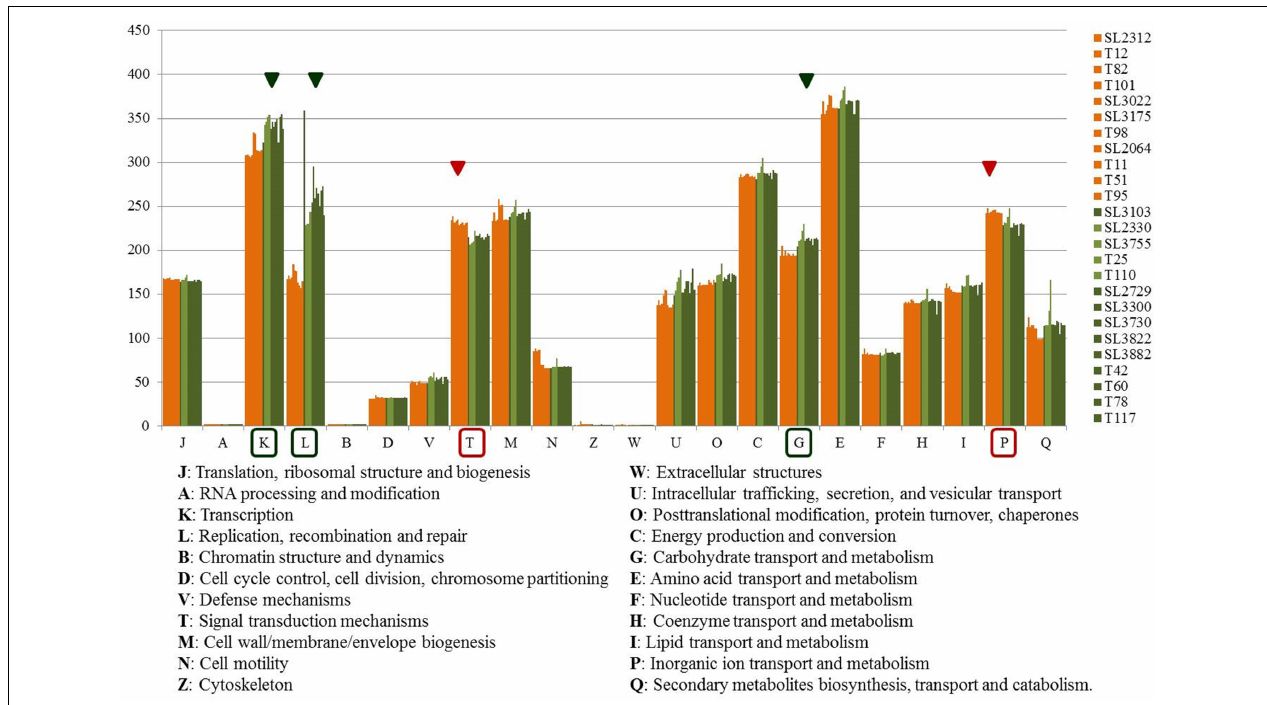
FIGURE 3 | Graph of COG functional categories of 25 Korean strains. Orange color represents phylotype IV-biovar 2 strains, and olive and green colors represent the phylotype I-biovar 3 and phylotype I-biovar 4 strains. The red triangle and box indicate the category with more genes in phylotype IV than in phylotype I, and the green triangle and box indicate the category with more genes in phylotype I than phyloytpe IV. Category S, genes of unknown function, is excluded from the